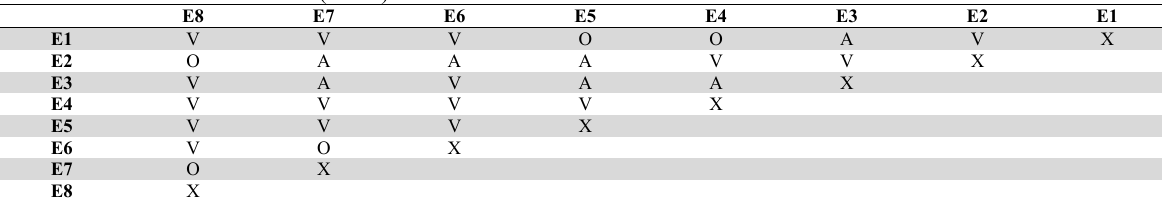
Structural Self-Interaction Matrix (SSIM)